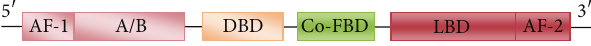
Figure 1: Schematic representation of the functional domains of PPARs. The PPARs are composed of four different domains. The A/B domain is located in the N-terminal region with AF-1 which is responsible for phosphorylation, C domain is involved in DNA binding domain, the D domain is the region of cofactors coupling and E/F domain is the specific domain for the ligands, associated with E/F domain is AF-2, which promotes the recruitment of cofactors necessary for the process of gene